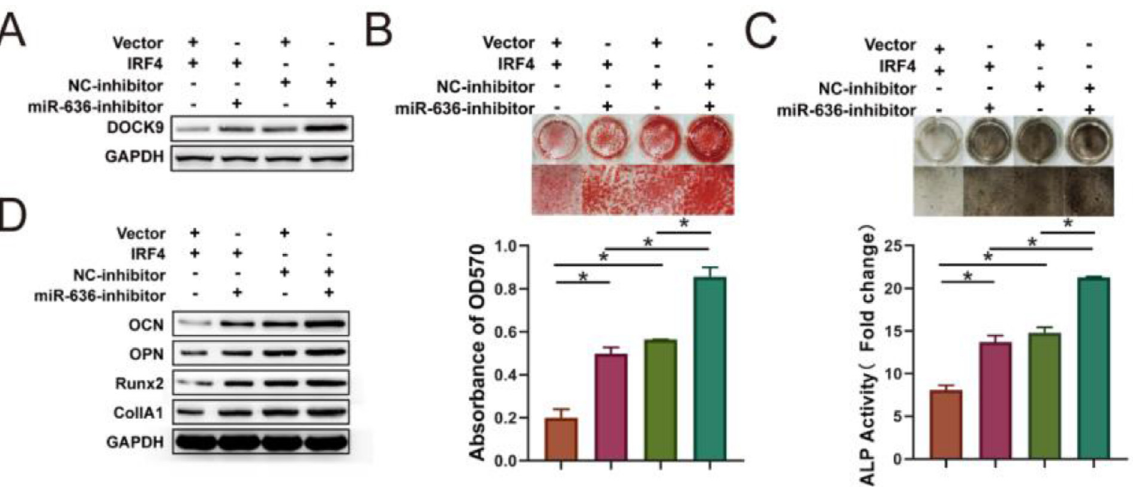
Fig. 5. IRF4 overexpression inhibits osteogenic differentiation of BM-MSCs via miR-636/DOCK9. (A) Western blotting was performed to detect DOCK9 expression. ARS (B) and ALP (C) staining assays were performed to determine osteogenic differentiation. Osteogenic differentiation biomarkers were determined by Western blot- ting (D). * p < 0.05. Data represent at least three independent sets of experiments.